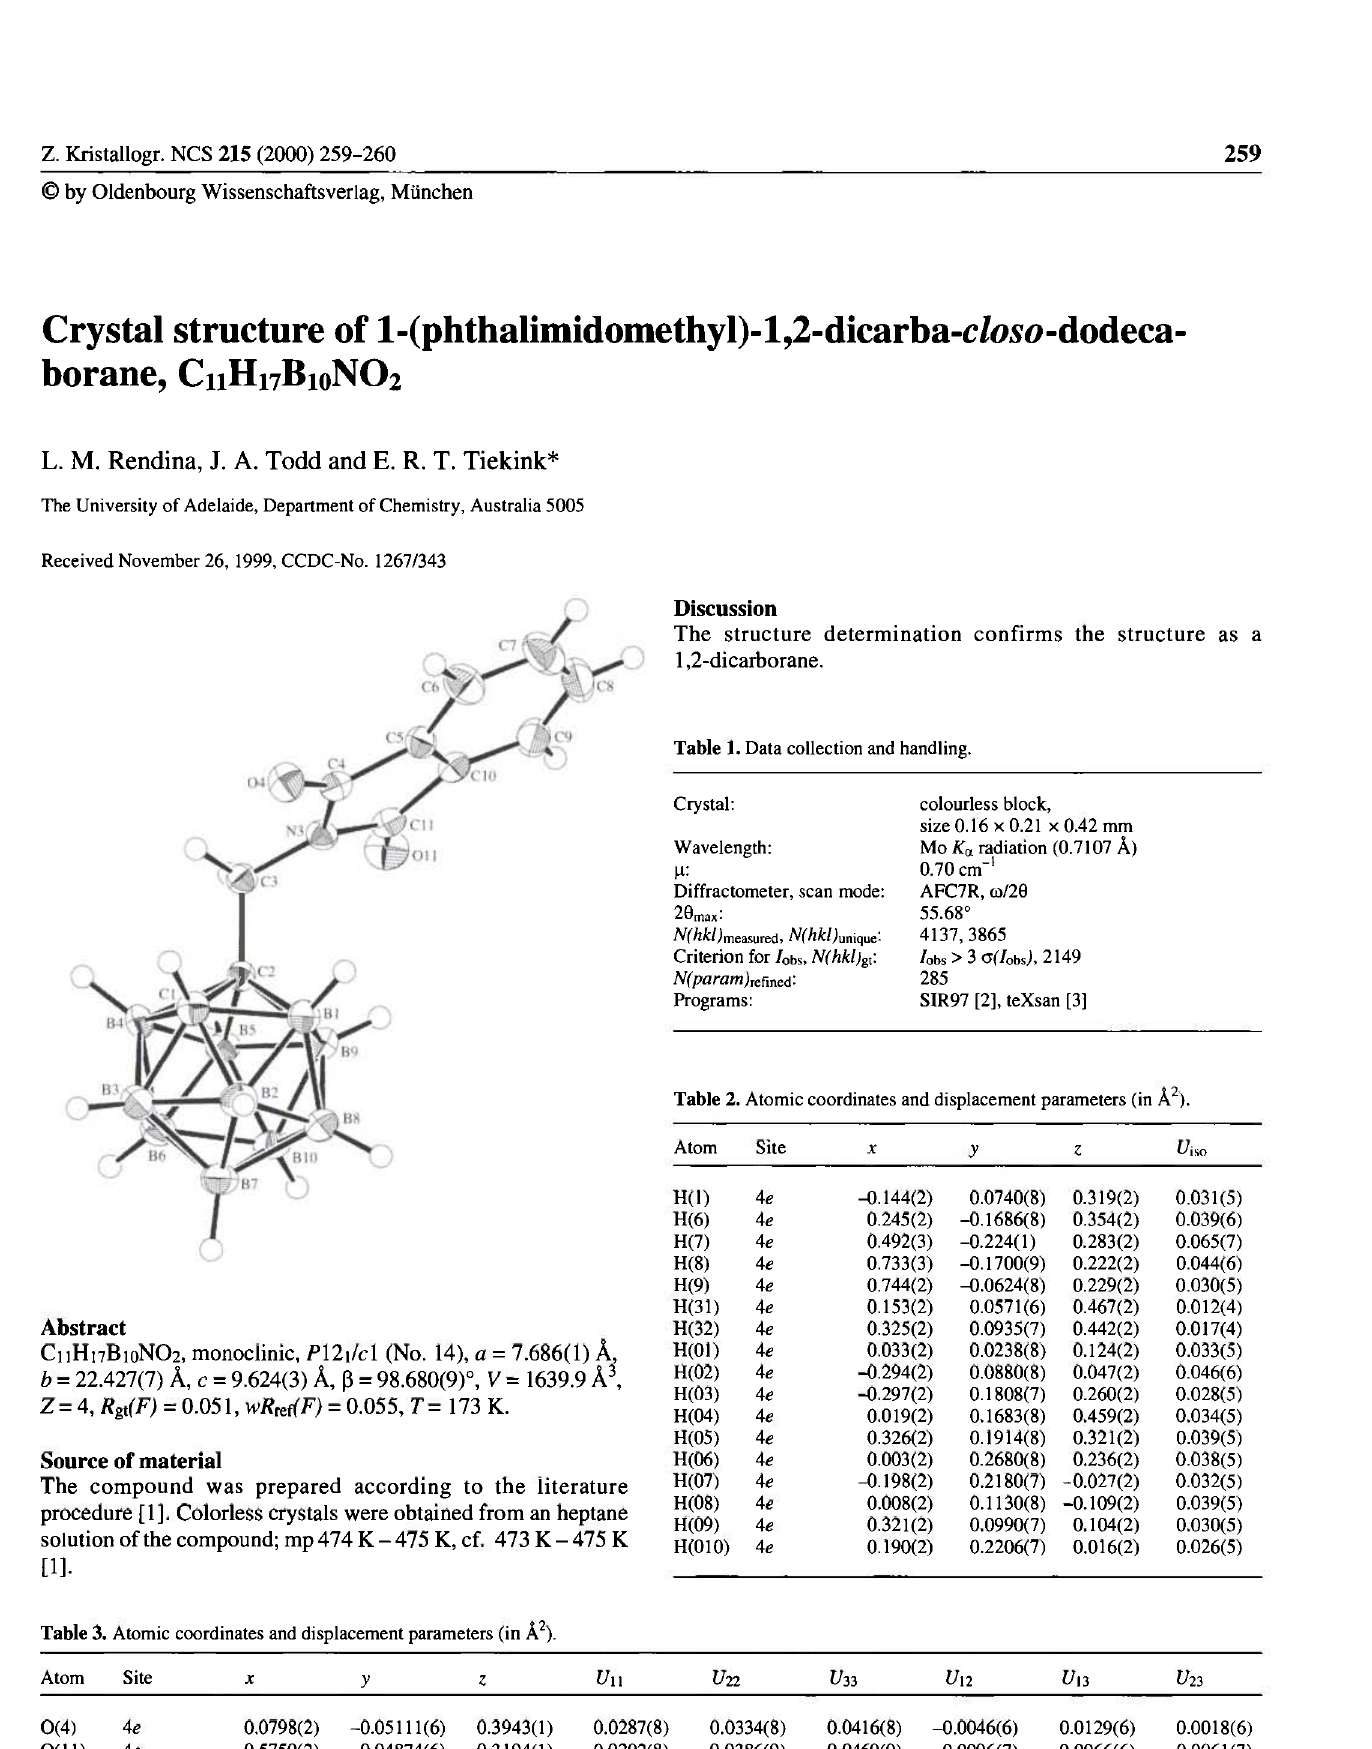
Table 3. Atomic coordinates and displacement parameters (in Ä 2